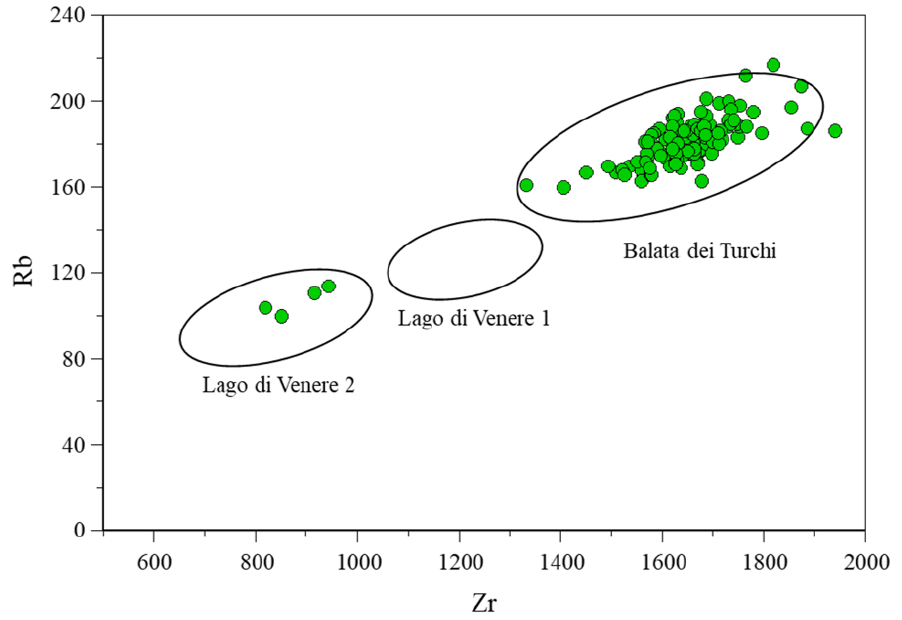
Figure 9: Graph of Zr vs. Rb shows most Pantelleria obsidian artifacts coming from Balata dei Turchi, and a few from Lago di Venere